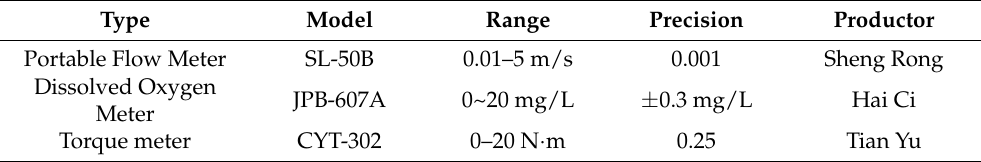
Table 1. Test instrument parameters.